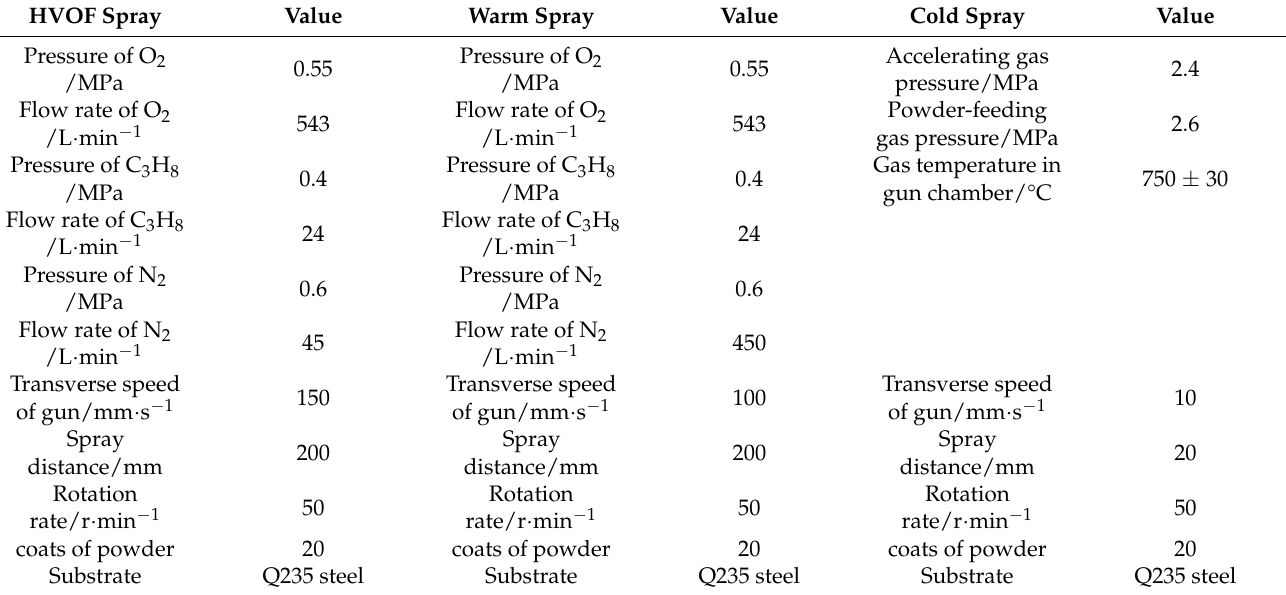
Figure 4. Schematic diagram of cold-spray system: (1) console cabinet, (2) Valve, (3) gas heater, (4) accelerating gas pipe, (5) spray gun, (6) powder feeder, (7) thermal couples, (8) display panel, (9) carrier gas, (10) powder feeder gas inlet, (11) accelerating gas inlet. Table 1. The detail spraying parameters of as-sprayed WC-17Co coatings.